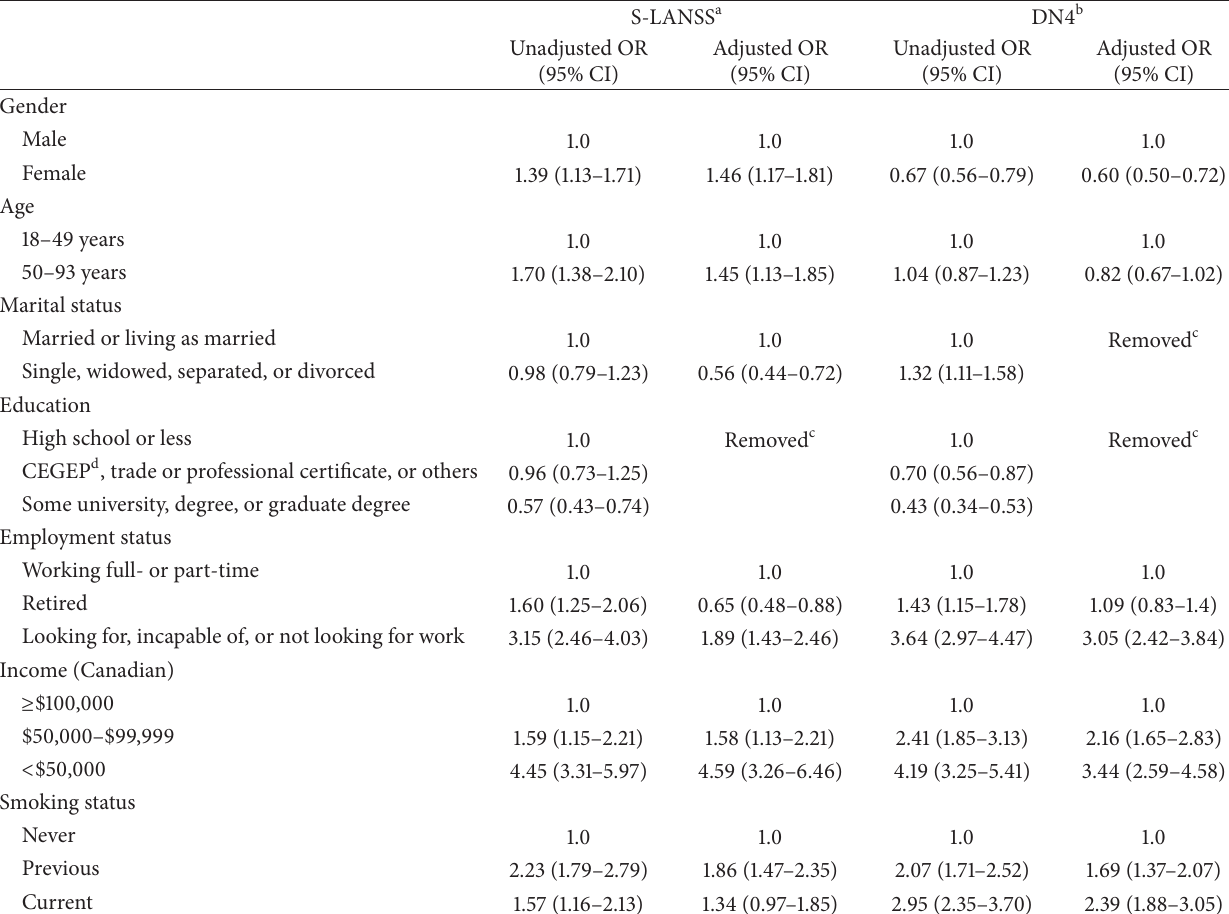
Table 4: Unadjusted and adjusted odds (95% CI) of likely or possible neuropathic pain using the S-LANSS and the